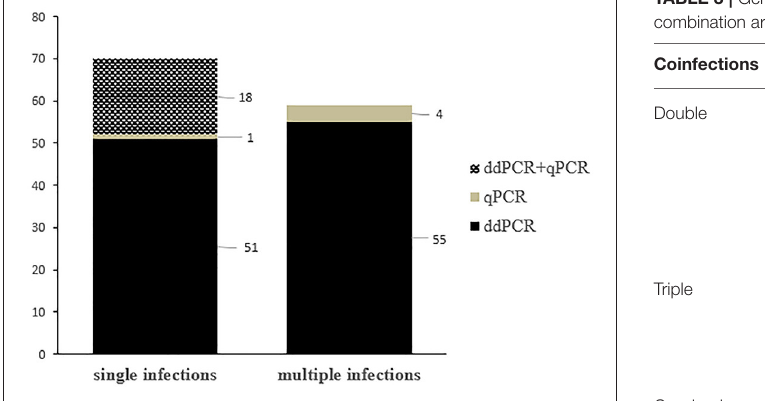
FIGURE 3 | Graphical representation of single and multiple OaPV infections, as detected by ddPCR and qPCR.